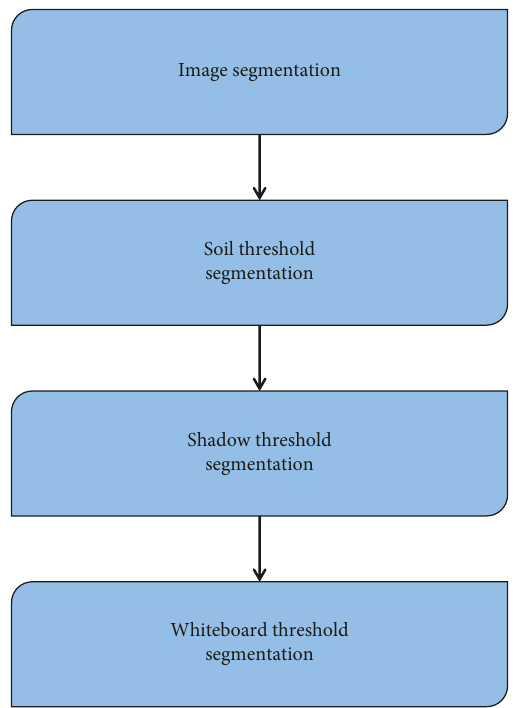
Figure 3: Flow chart of image